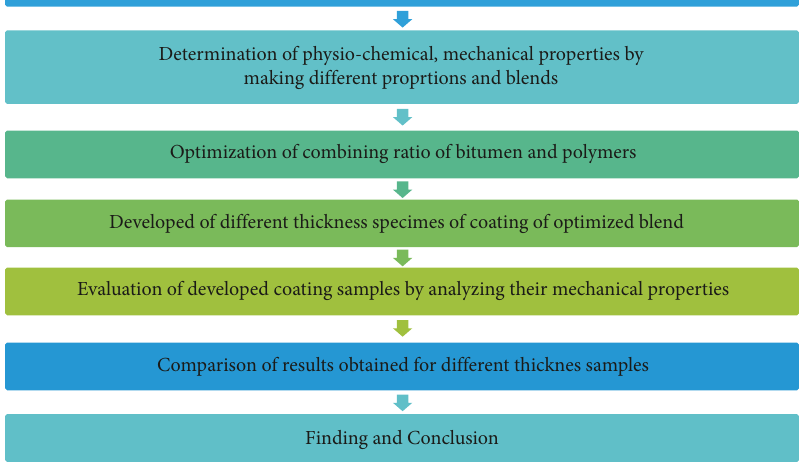
Figure 5: Development approach of protective coatings.